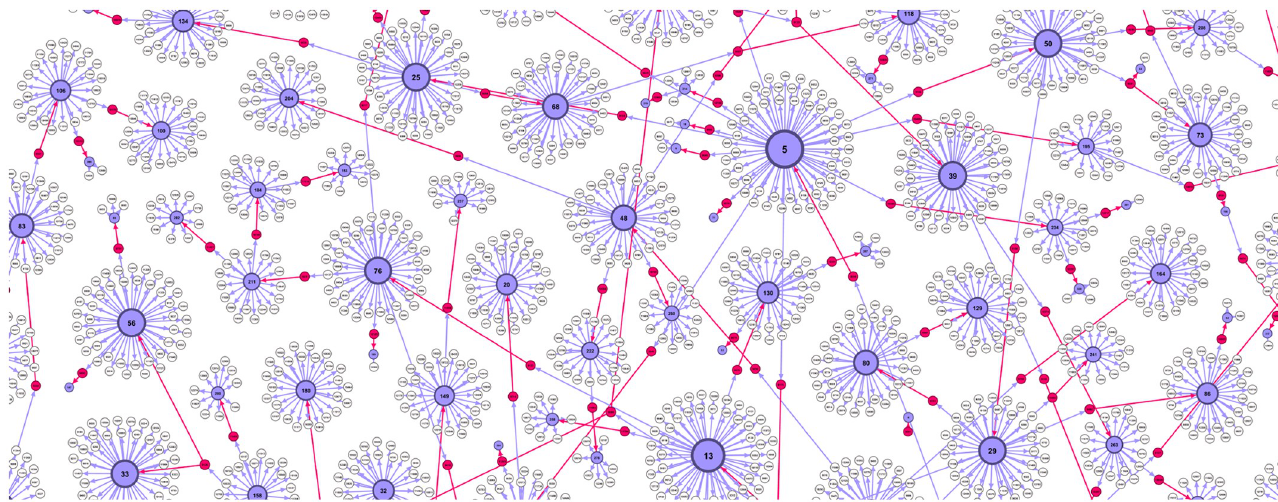
Fig 2. Zoom-in the directed bipartite network. Hnodes (blue) and created by them Vnodes (pale) within the first 72 hours ( λ 0 = 0.23, with mutations). Infection transmission occurred through virus nodes, which are indicated by red colour, in the direction of the edge. The amount of Vnodes emitted by one Hnode is proportional to its susceptibility factor and the duration of its stay among active carriers. Among white Vnodes are recent ones that still can infect a new exposed agent; otherwise, each Vnode is non-infective four hours after its appearance.